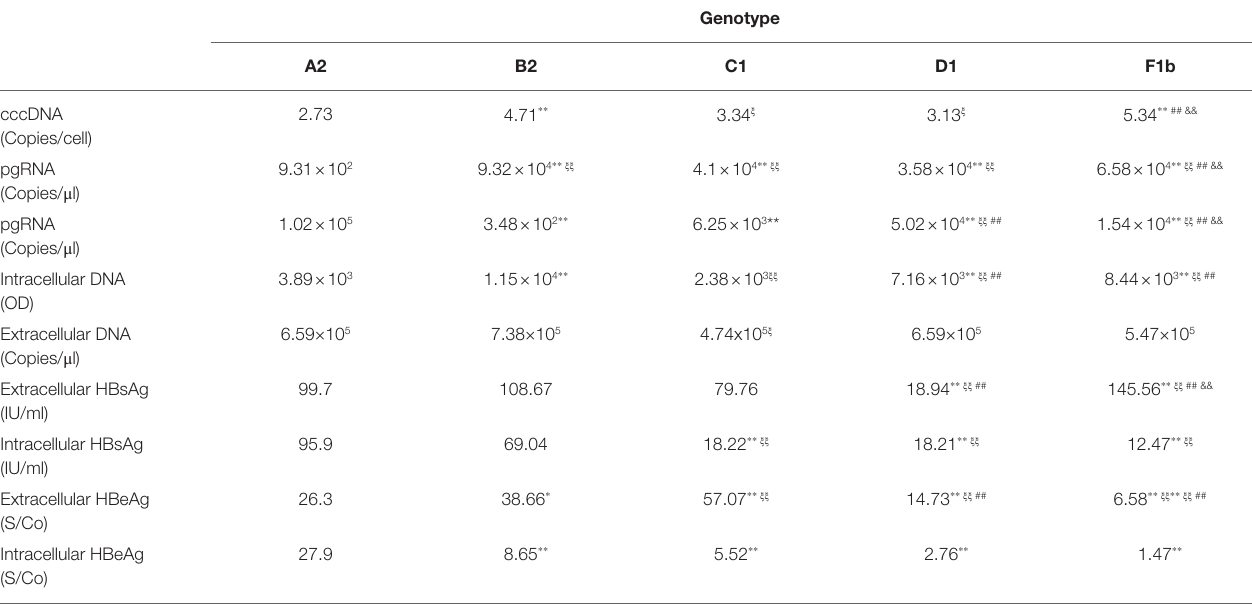
TABLE 1 | Viral replication and protein expression levels of each